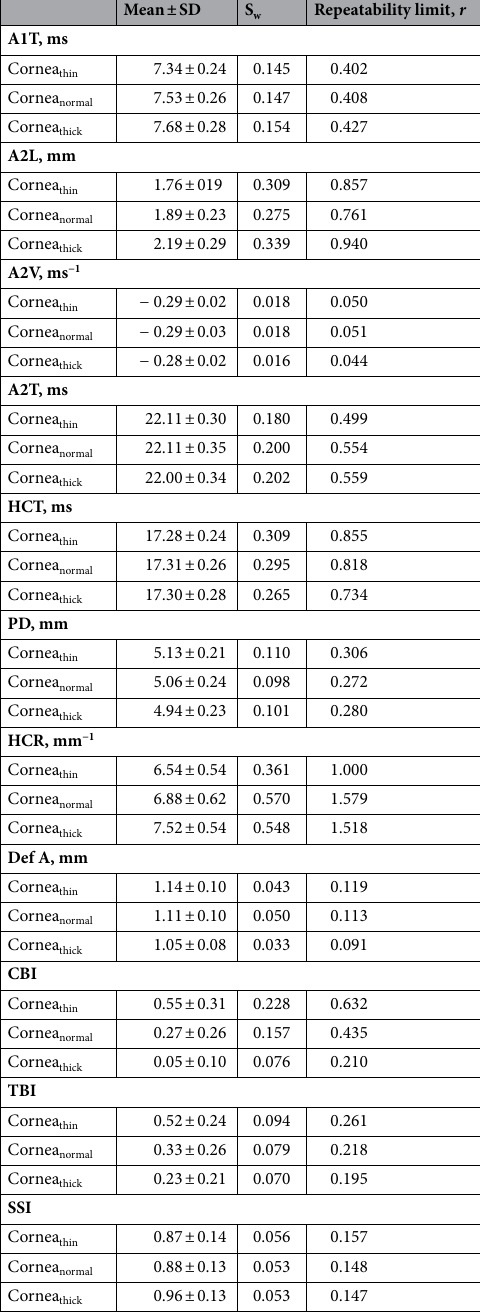
Table 2. The measurement repeatability of Corvis ST in thin, normal and thick corneas. IOP intraocular pressure, bIOP biomechanically corrected IOP, CCT(c) central corneal thickness by Corvis ST, DA ratio 2